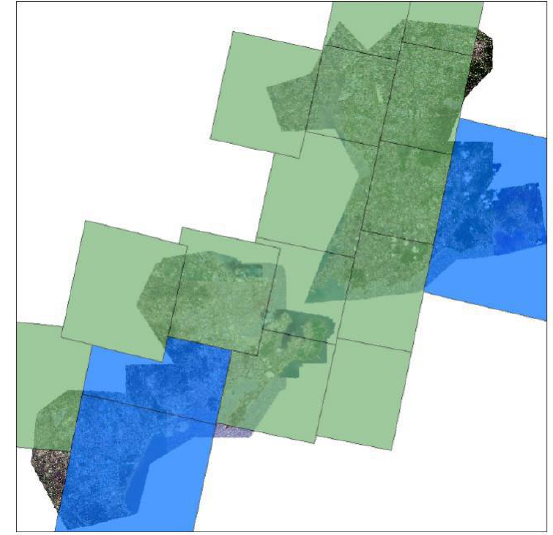
Figure 1. Satellite images used in this work